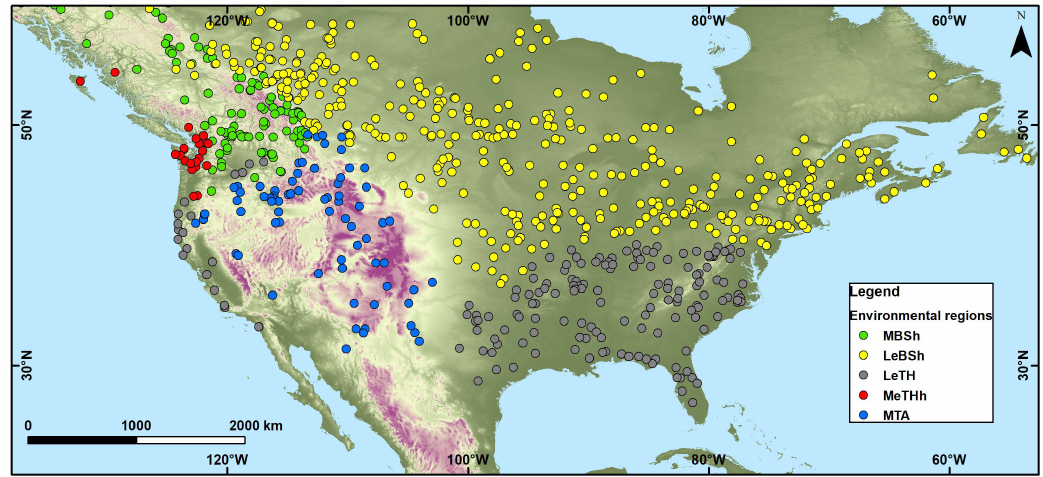
Figure 4. Geographic distribution of watersheds included in the study. The color of the dot indicates the environmental region each watershed was grouped into by the cluster analysis based on environmental